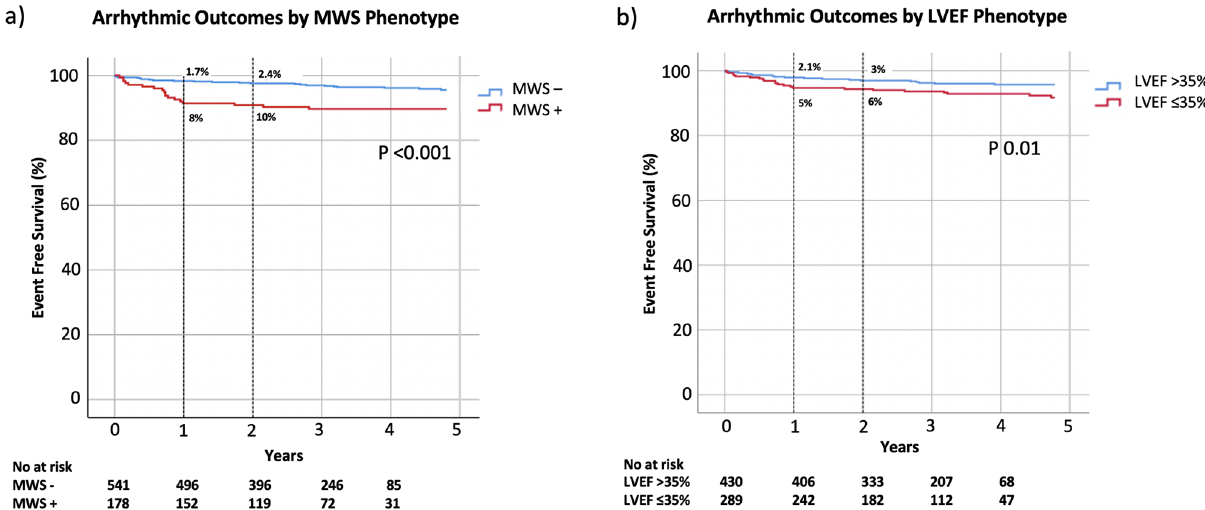
Figure 7. Kaplan–Meier event free survival curve for the secondary arrhythmic composite outcome of appropriate ICD therapy, sudden cardiac death (SCD), survived sudden cardiac arrest (SCA), or sustained VT requiring cardioversion with and without ( a ) mid-wall striae (MWS) fibrosis, and ( b ) LVEF ≤